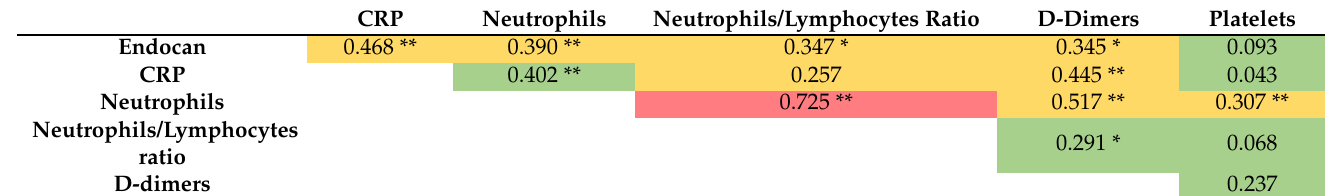
Table 2. Correlations of admission values in COVID-19 patients.